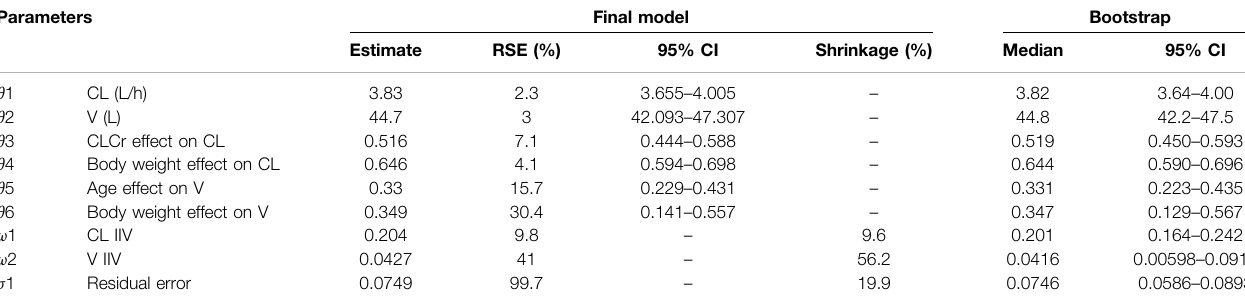
TABLE 2 | Parameter estimates and bootstrap of the fi nal population PK model of vancomycin for adults and pediatric patients. Parameters